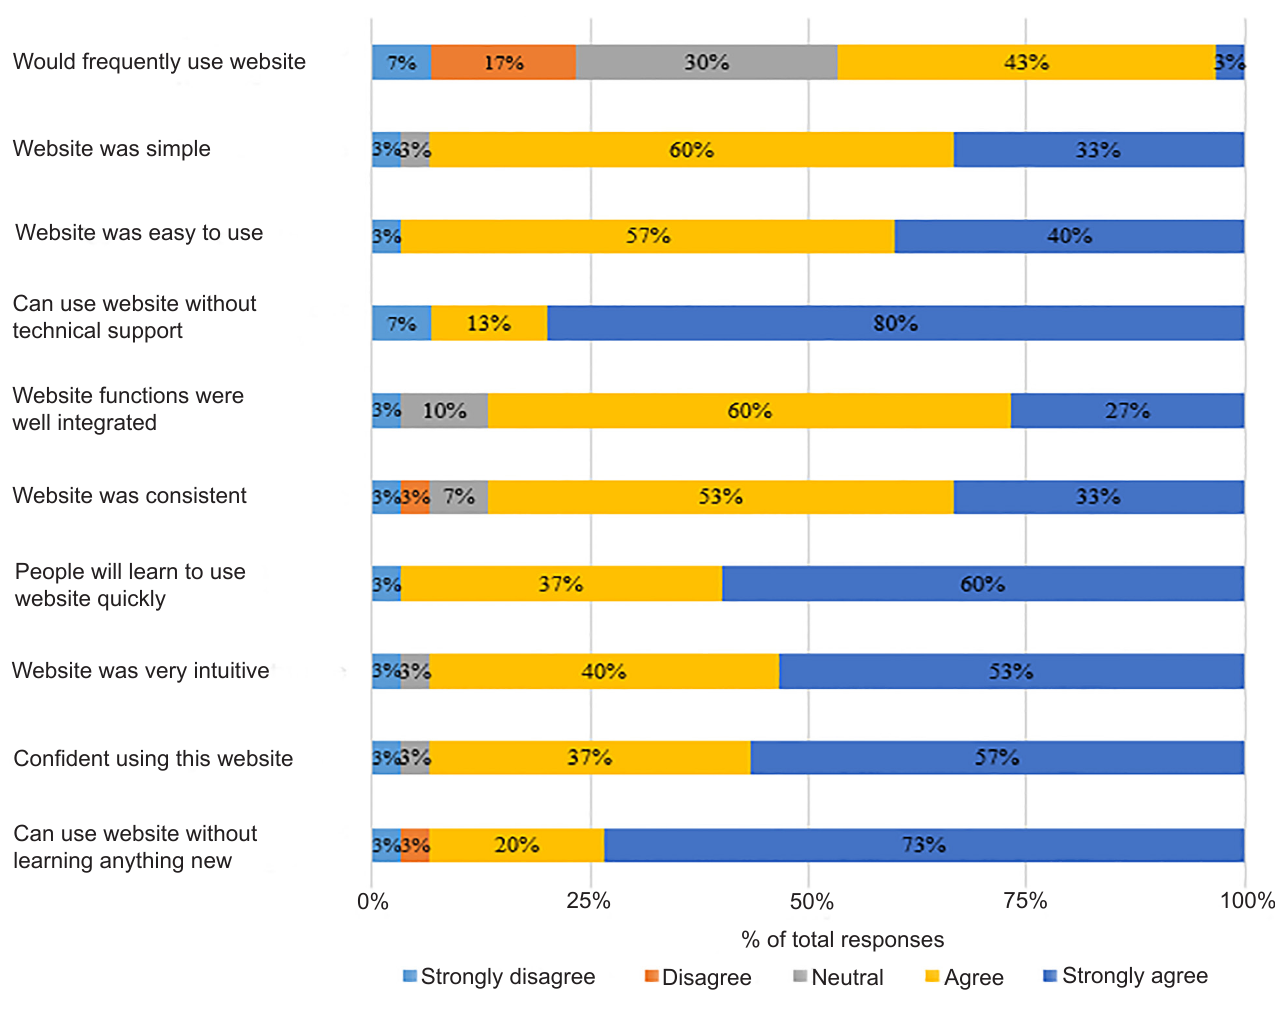
Figure 1. System Usability Scale questionnaire responses. Cronbach’s Alpha=0.95